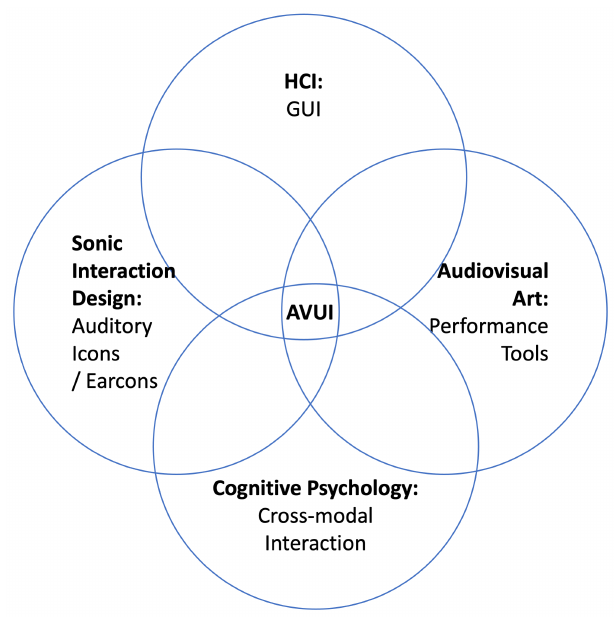
Figure 3. Diagram situating AVUI in the intersection of the identified related